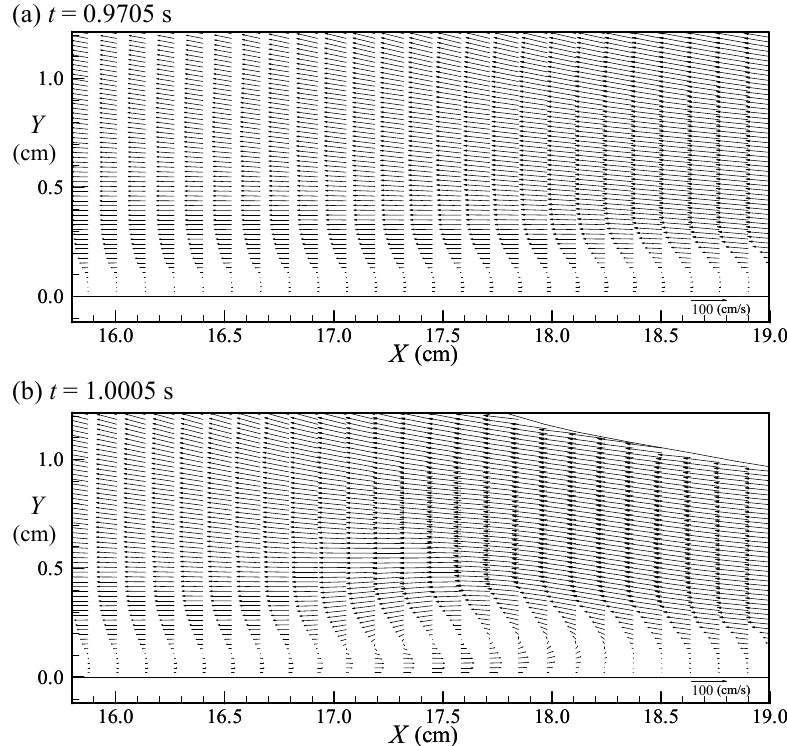
Figure 12. The instantaneous near-bottom velocity fields at t = ( a ) 0.9705 s; and ( b ) 1.0005 s.